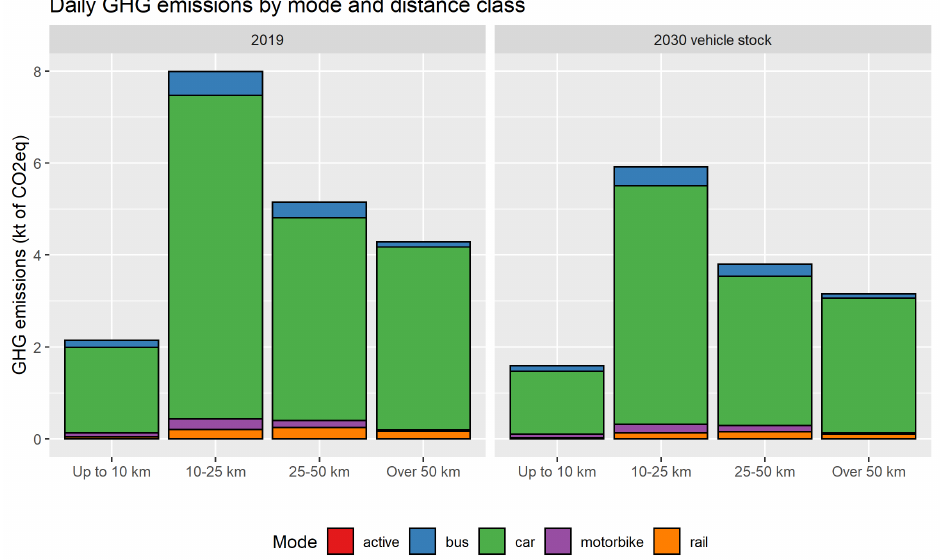
Figure 6. Annual GHG emissions of daily trips in Lombardy, by mode and distance class, considering a WTW